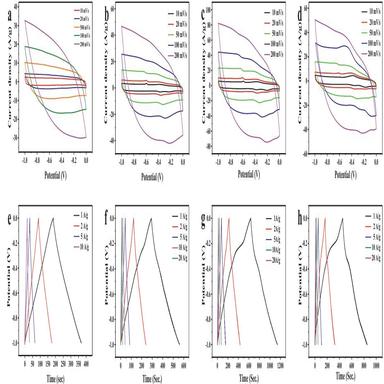
Electrochemical properties of four electrode materials in a three-electrode system: the CV curves of (a) AC, (b) AC@MnCu-16, (c) AC@MnCu-32, (d) AC@MnCu-48 and GCD curves of (e) AC, (f) AC@MnCu-16, (g) AC@MnCu-32, (h) AC@MnCu-48.